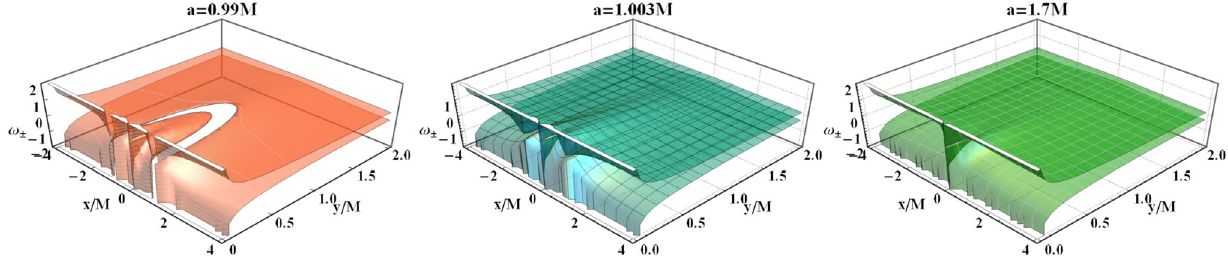
Fig. 4 Plots of the frequency surfaces ω ± ( r ,θ) as functions of the radial distance r / M in Cartesian coordinates ( x , y ) for different spin values a , including BH s and NSs